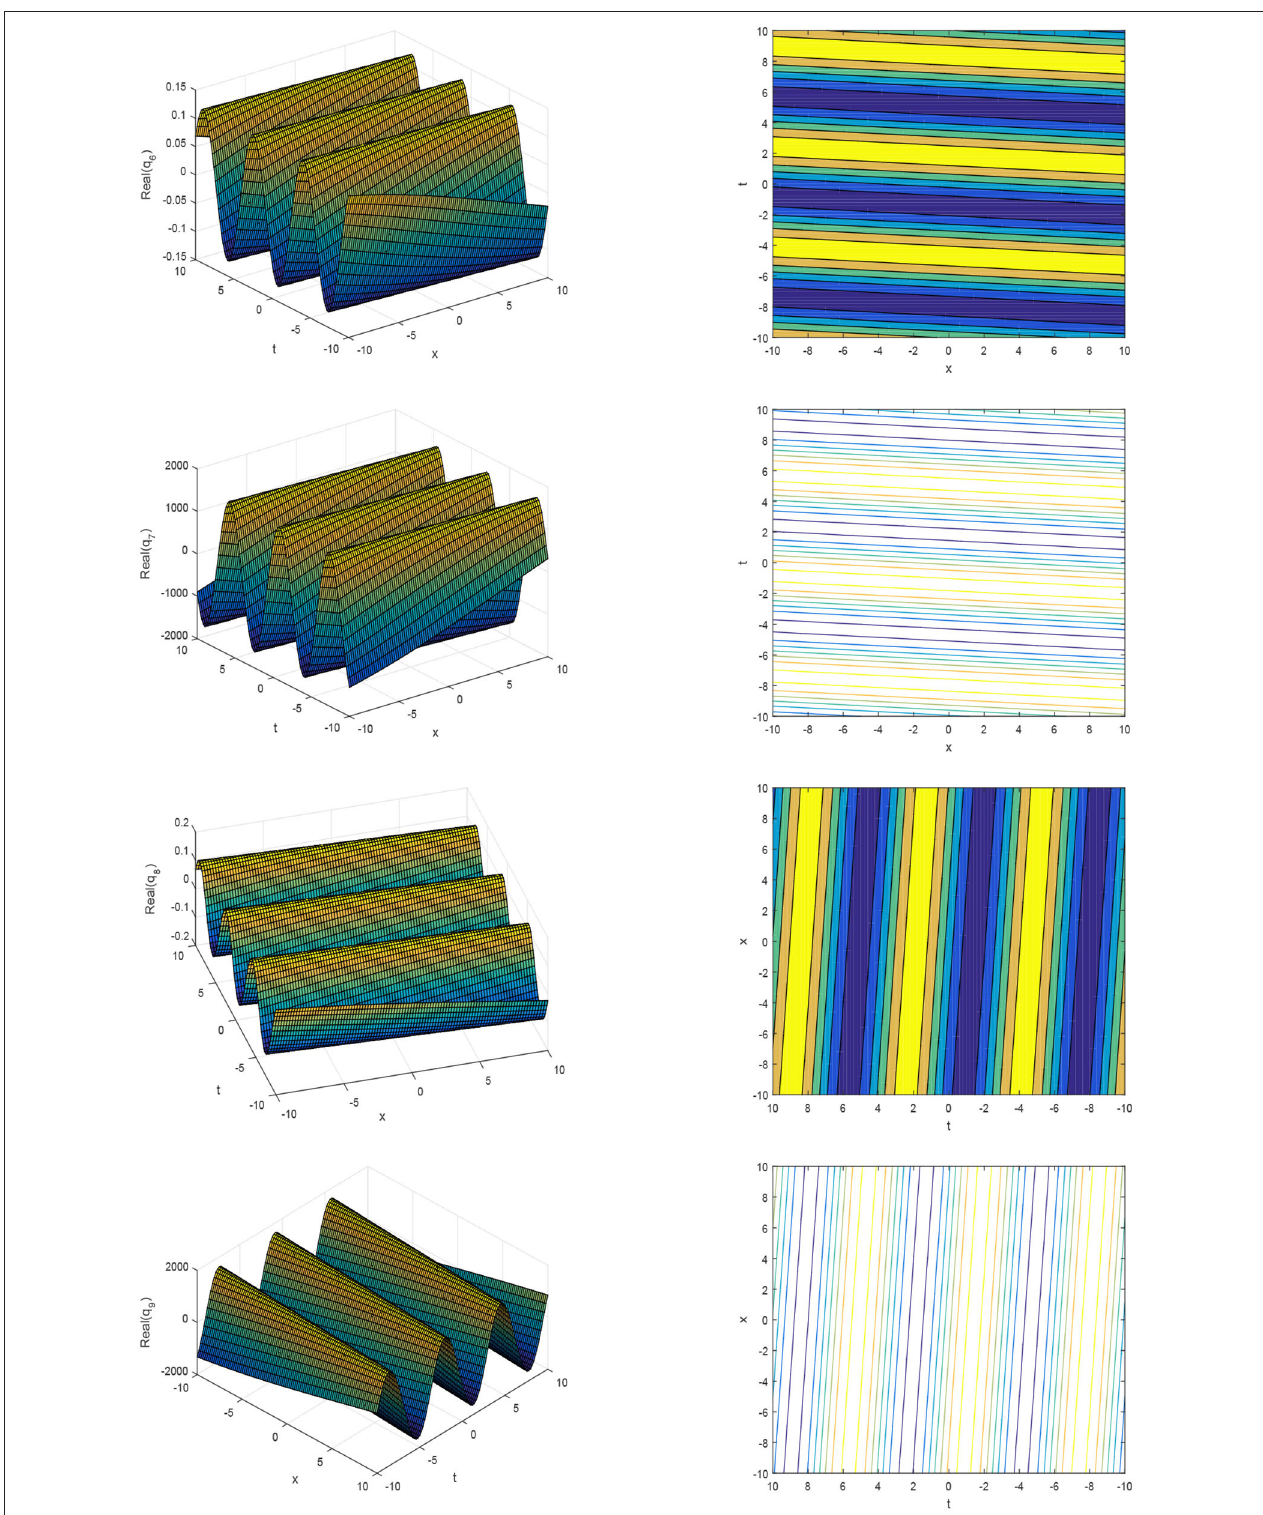
FIGURE 2 | The 3D plots and contour plots of the real part of solution q 6 ( x , t ) to q 9 ( x , t ) for different parameters.